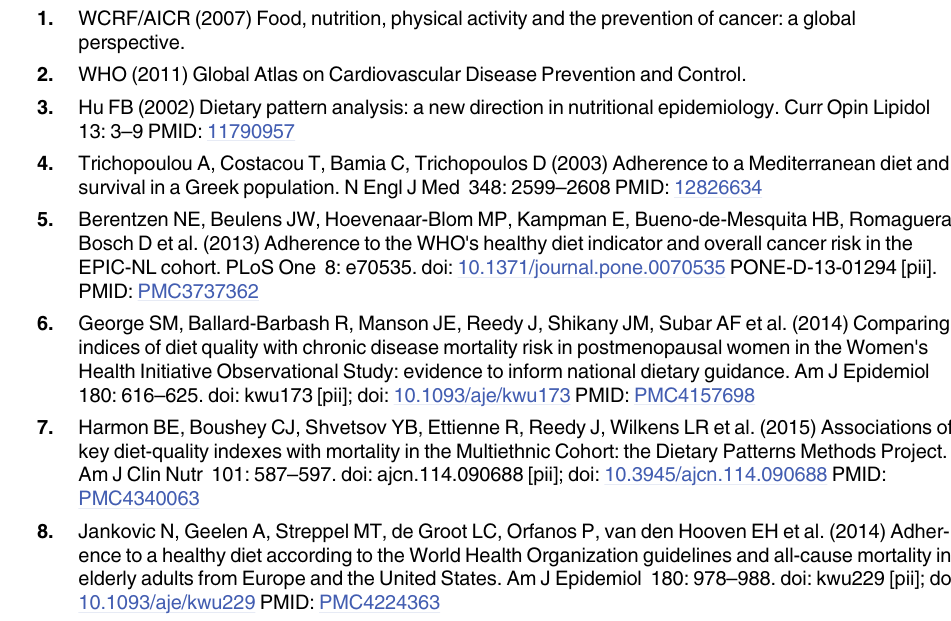
S6 Table. Geographical differences in dietary scores across EPIC centres. S7 Table. Age and sex specific multivariate hazard ratios (Model 2: adjusted for age and lifestyle risk factors) for 10-year mortality risk for a 1SD increase of score among 451,256 participants of the EPIC study. a Model including the following predictors: age at baseline, BMI (continuous), Physical activity (Cambridge index), smoking status (3 categories) and edu- cational level, unless otherwise stated. Stratified by study center. b Model including the follow- ing predictors: age at baseline, BMI (continuous), Physical activity (Cambridge index), smoking status (3 categories) and educational level, unless otherwise stated. Stratified by sex and study center. c HR for the increase of 1 SD of score. d Model only including HLI, age and educational level because BMI, physical activity, smoking are components of the Healthy Life- style Index, n = 376,553. e Model only including WCRF score, smoking and educational level as BMI and physical activity are components of the WCRF score, n =